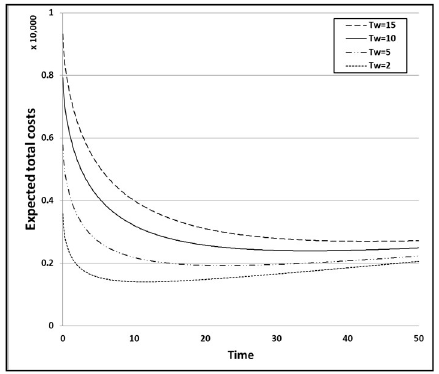
Figure 13. Expected total cost subject to the warranty period for the 2 nd condition.